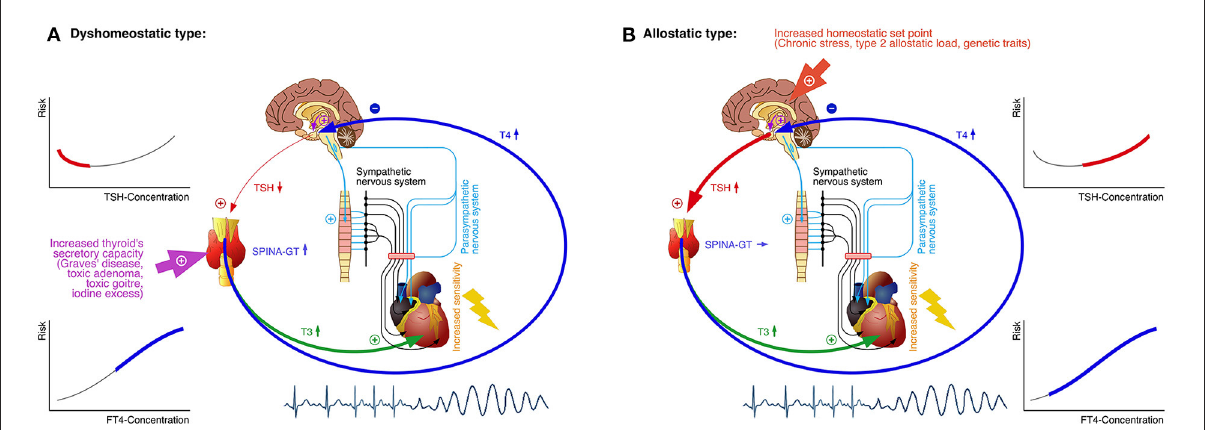
FIGURE10 An integrated model for the association between thyroid homeostasis and major cardiovascular events. In the dyshomeostatic type of thyrogenic arrhythmia elevated FT4 concentration, caused by primary thyrotoxicosis, increases the risk for severe arrhythmia as a major cause for cardiovascular mortality. The TSH concentration is reduced in this case, represented by the left, declining, branch of the U-shaped relation between TSH level and risk (A) . In the allostatic type, mainly caused by type 2 allostatic load and genetic traits, the set point of thyroid homeostasis is raised, resulting in increased TSH and FT4 concentration and subsequently elevated risk for arrhythmia. This situation is mirrored in the right, rising, branch of the relation between TSH concentration and cardiovascular risk (B) . In any case, elevated concentrations of T3, T4 and other T3-agonistic thyroid hormones increase the sensitivity to catecholamines and sympathetic signaling ( via upregulated expression of beta1 and beta2 adrenoceptors), thereby contributing to reduced stress tolerance. SPINA-GT, “gain of thyroid,” i.e., thyroid’s secretory capacity